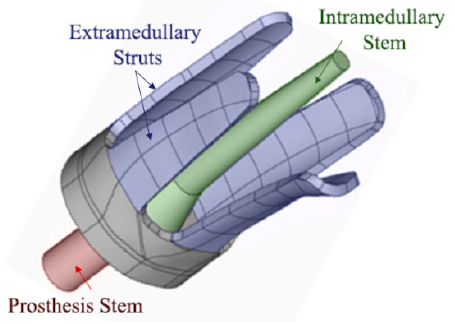
Figure 2. The novel customisable osseointegrated implant design introduced by Russ et. al. [2].